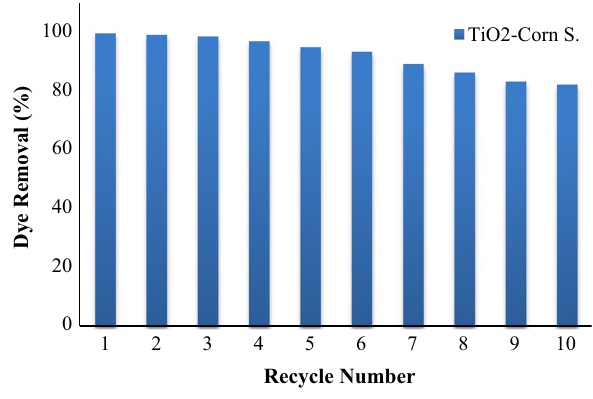
Fig. 11 Effect of reusability capability of TiO photocatalytic removal rate of RB5 azo dye (pH 3.0, 25 °C, 300 rpm, 30